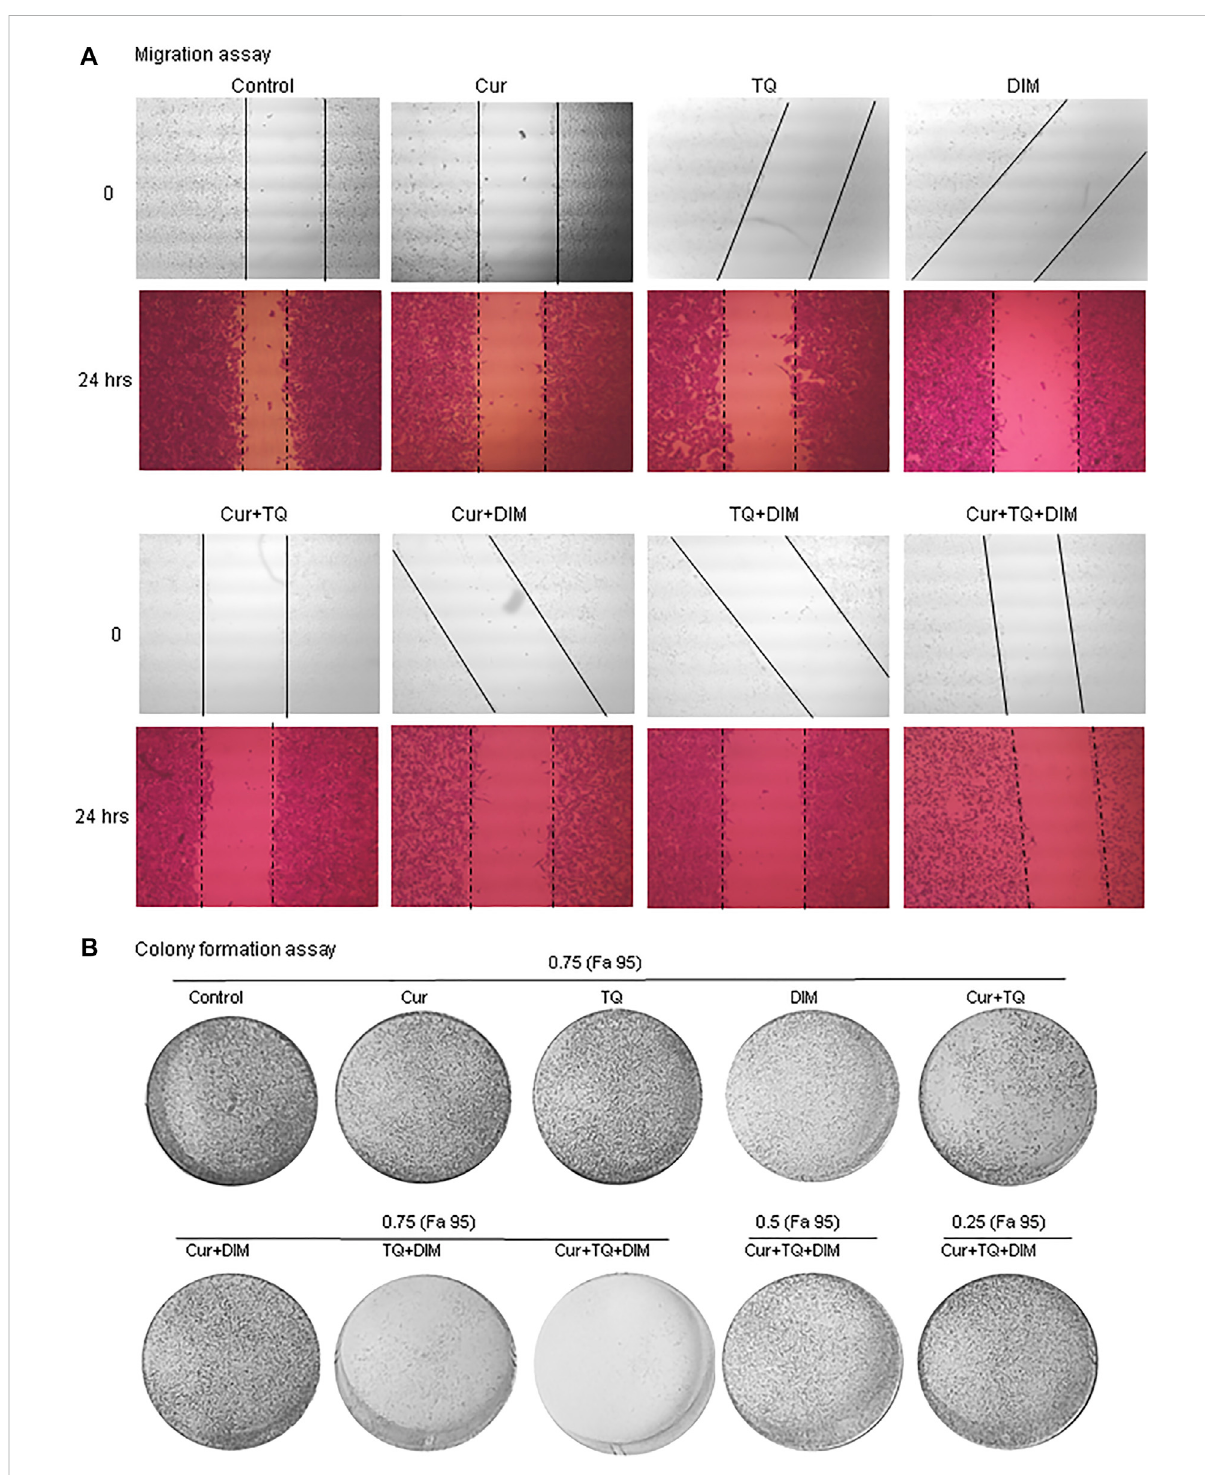
FIGURE 4 Migration andcolonyformationassaysof A549. (A) Migrationassay of control andA549-treated with0.75(Fa 95) of Cur, TQ, DIM, Cur + TQ, Cur + DIM, TQ + DIM, and Cur + TQ + DIM at 0 and 24 h. (B) colony formation assay of control, A549-treated with 0.75 (Fa 95) of Cur, TQ, DIM, Cur + TQ, Cur + DIM, TQ + DIM, and Cur + TQ + DIM, A549-treated with 0.50 (Fa 95) of Cur + TQ + DIM, and A549-treated with 0.25 (Fa 95) of Cur + TQ +